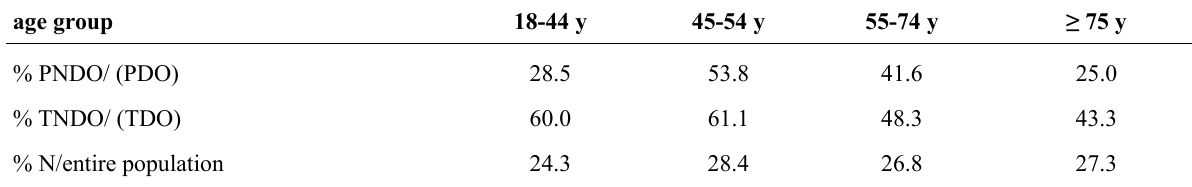
Table 3 - Ratio of women with neurological disease (N) in each sub group of DO and in each age group. age group 18-44 y % PNDO/ (PDO) % TNDO/ (TDO) % N/entire population